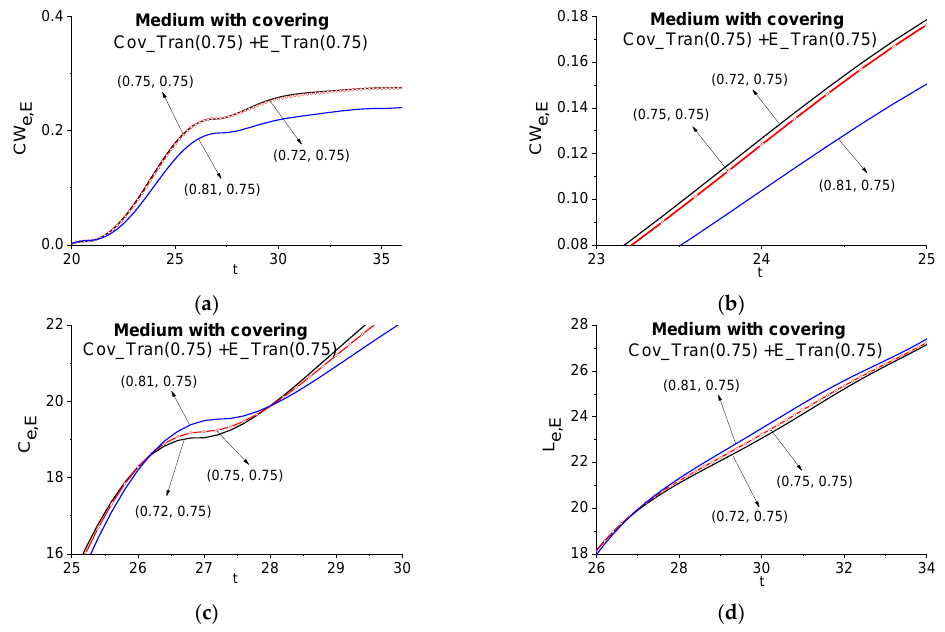
Figure 10. Time-dependent ICC CW e,E ( a ), ( b ), C e,E ( c ), L e,E ( d ) calculated at the frequency ν = 0.75 in the time intervals t = [20, 36] ( a ), [23, 25] ( b ), [25, 30] ( c ), [26, 34] ( d ) for the pair of pulses transmitted through the medium with covering (Cov_Tran—a signal under analysis) and without covering (E_Tran—a standard signal).